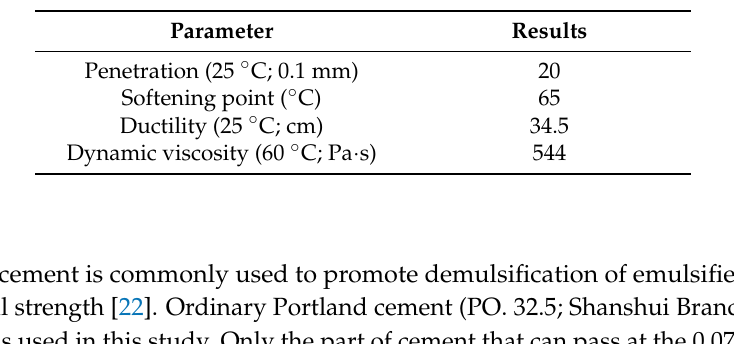
Table 4. Properties of recycled asphalt